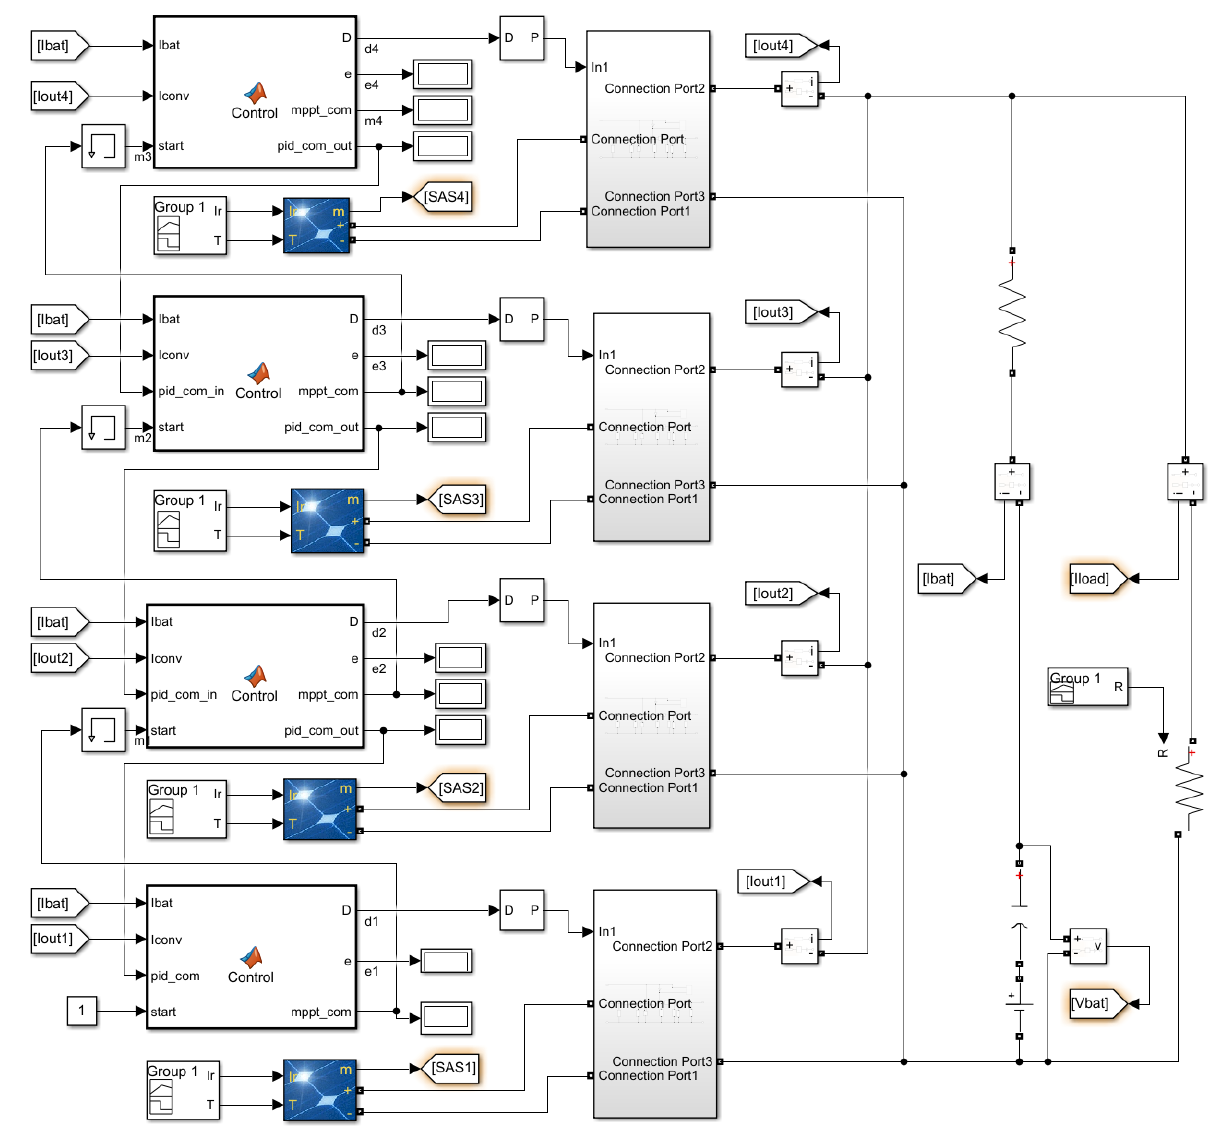
Figure 10. Simulink model of the SMPT technique. The subsystem blocks (in grey) model the SEPIC converters directly from their circuit schematics. The blue blocks are library blocks for photovoltaic arrays.